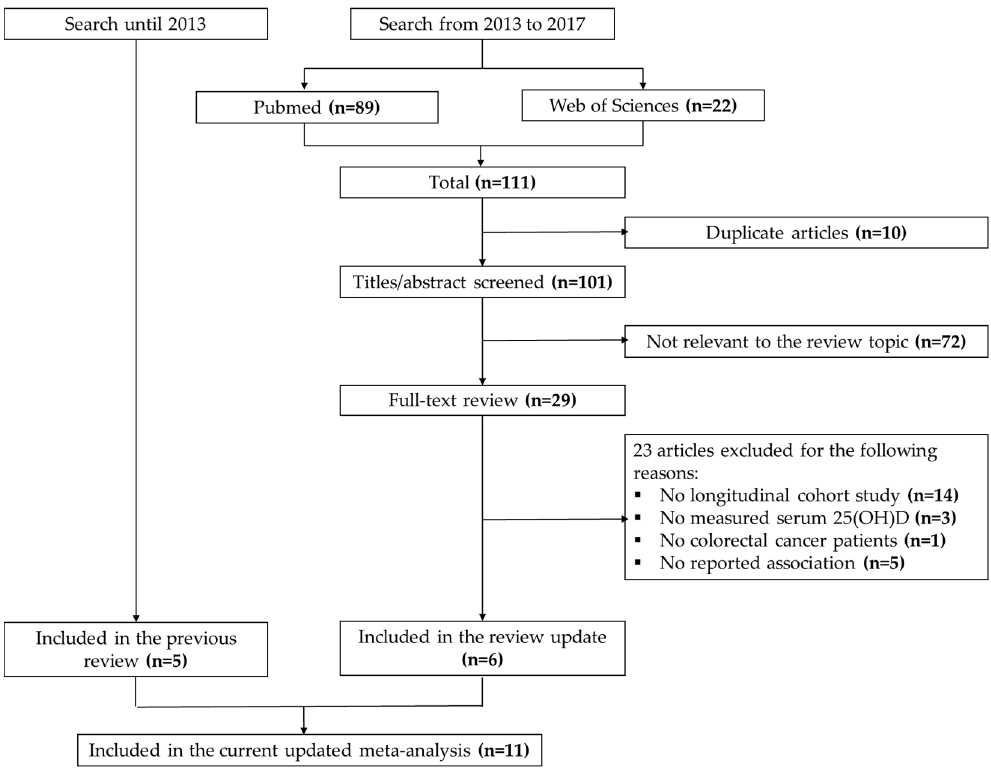
Figure 1. Flow diagram of the systematic literature search for colorectal cancer in PubMed and Web of Science.